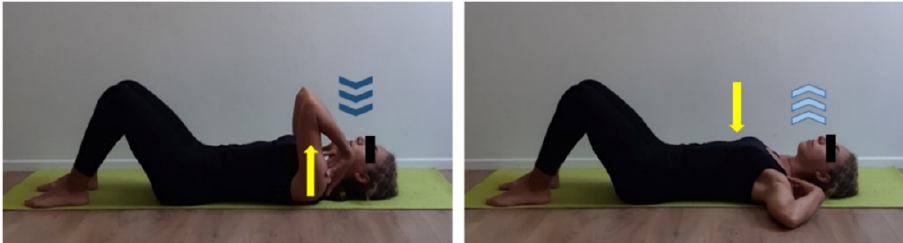
Figure 5. Scapular mobilization exercise in supine position. Supine position, flex both legs, set feet (yellow arrow) and flexing forearms. Inhale (dark blue arrows) then exhale (light blue arrows) and